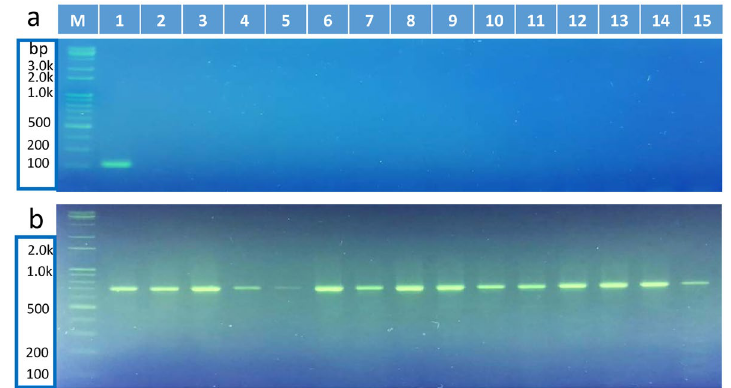
Figure 1. Sf00067 was a FAW specific biomarker. ( a ) When the Sf00067 F3 and B3 pair was used to perform PCR with genomic DNA from 15 moth species, only a 209 bp DNA band was detected from FAW genomic DNA. ( b ) LCO1490 and HCO2198 primers were used as loading controls. Moth species used in this study were as follows: 1. FAW, 2 . Axylia putris , 3 . Mythimna loreyi , 4. Discestra trifolii , 5. Hermonassa cecilia , 6.